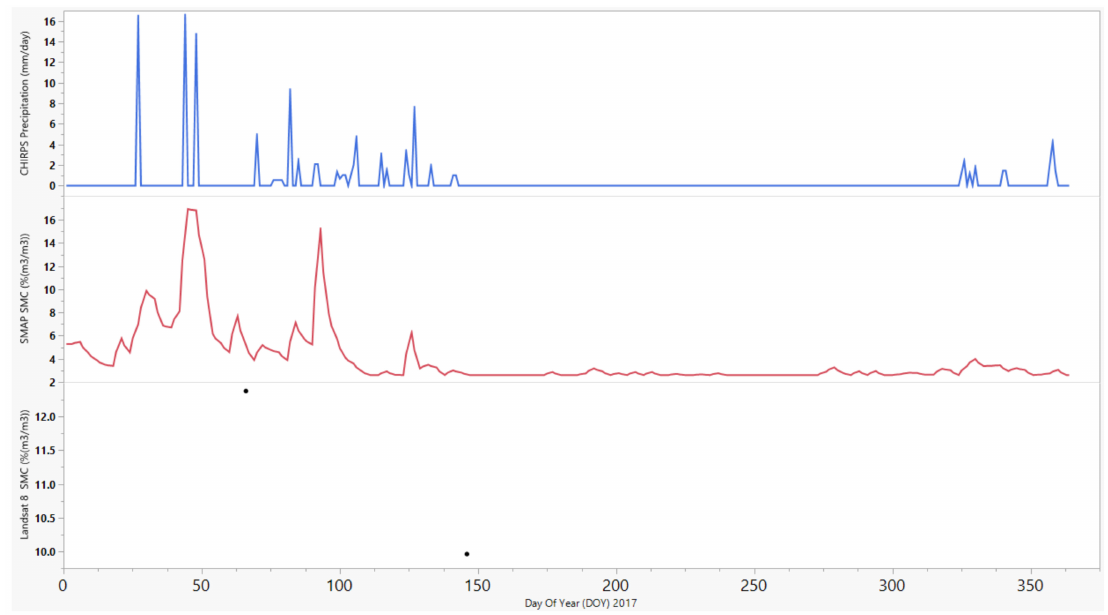
Figure 9. Comparison between SMAP soil moisture product and Landsat 8 soil moisture in days of the year (DOY) 66 and 146 (7 March and 26 May) of 2017. Relationship between daily precipitation events and soil moisture. Daily soil moisture conditioned on previous day